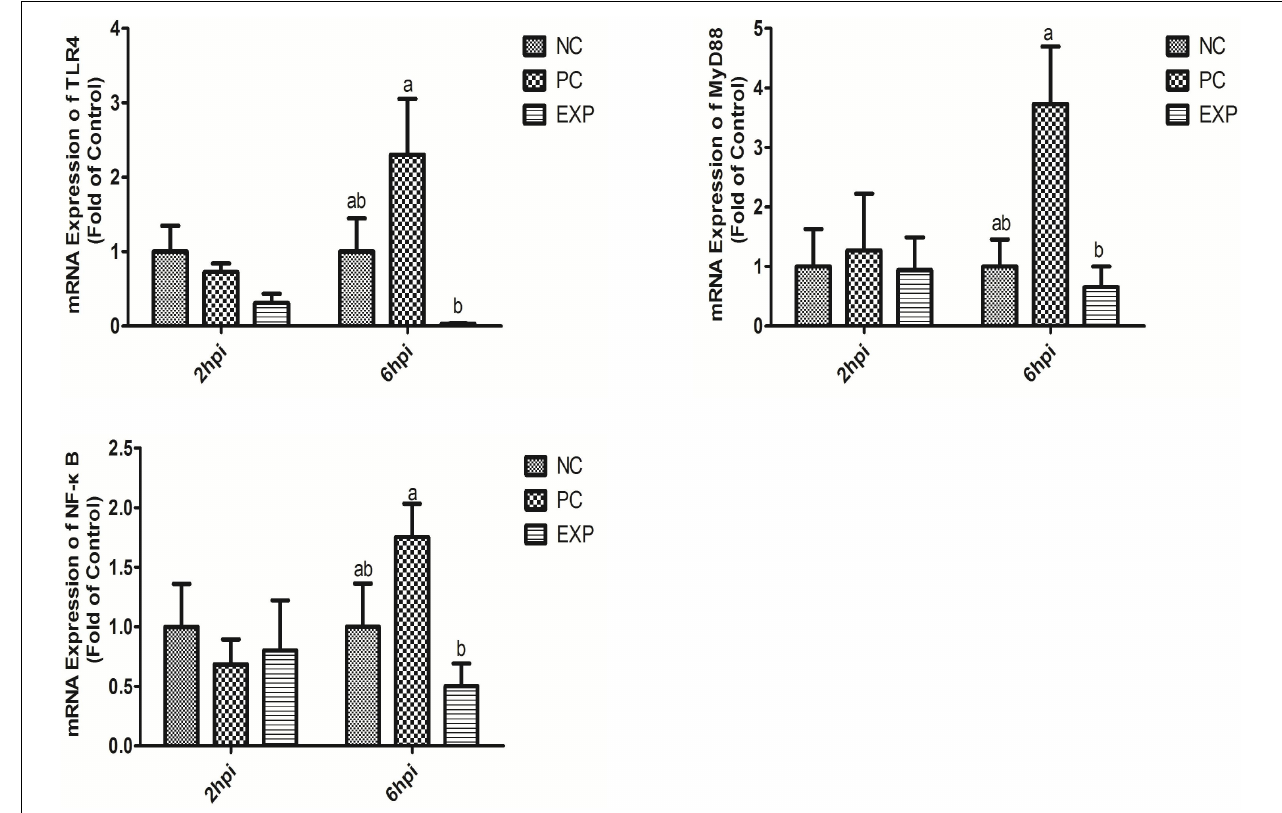
FIGURE 5 | Clostridium butyricum supressed inflammation via TLR4-, MyD88-, and NF- κ B-dependent pathways. Relative mRNA expression of TLR4, MyD88, and NF- κ B in intestinal epithelial cells were estimated by real-time PCR. The bars represent the mean ± SD ( n = 6/group). Different letters over the bars indicate statistically differences between the groups ( P < 0.05), same letters over the bars indicate no statistically differences between the groups ( P > 0.05). NC, the negative control group; PC, the positive control group; EXP, C. butyricum + S. enteritidis